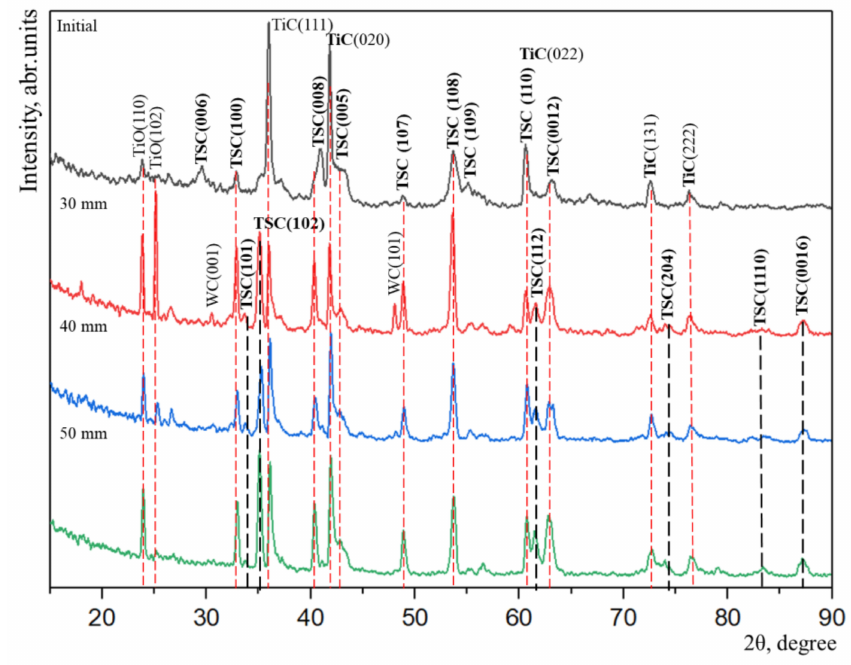
Figure 5. Diffractograms of detonation coatings based on Ti-Si-C before and after the PPT. Images of the thin structure of the coatings obtained by viewing in an electron mi- croscope were used to classify the morphological features of the structure. The phases were identified by images confirmed by microdiffraction patterns and dark-field images obtained in the reflexes of the corresponding phases. In order to identify the crystal bonds between Ti 3 SiC 2 and TiC, the Ti 3 SiC 2 /TiC interfaces were studied by transmission electron microscopy. The crystallographic structure and bonding between the Ti 3 SiC 2 and TiC phases were determined by diffraction methods on a selected area and by